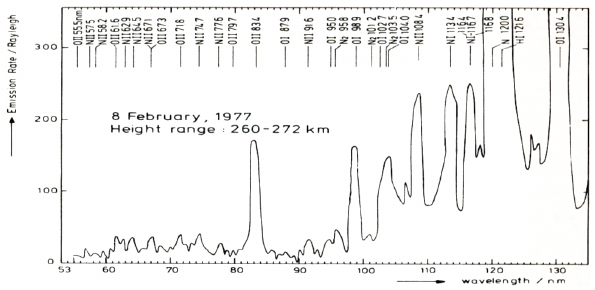
Figure 25. Emission spectrum of a diffuse aurora on 22 January 1977 over Andøya, Norway (Fischer and Schmidtke, 1980; copy- right permission granted by Wiley publishing).